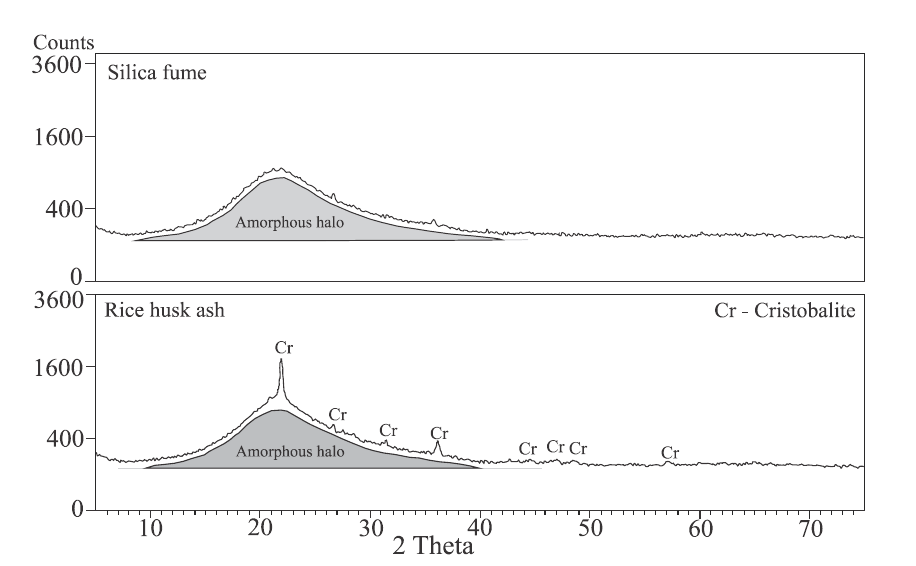
Figure 3. X-ray diffractograms of the silica fume and rice husk